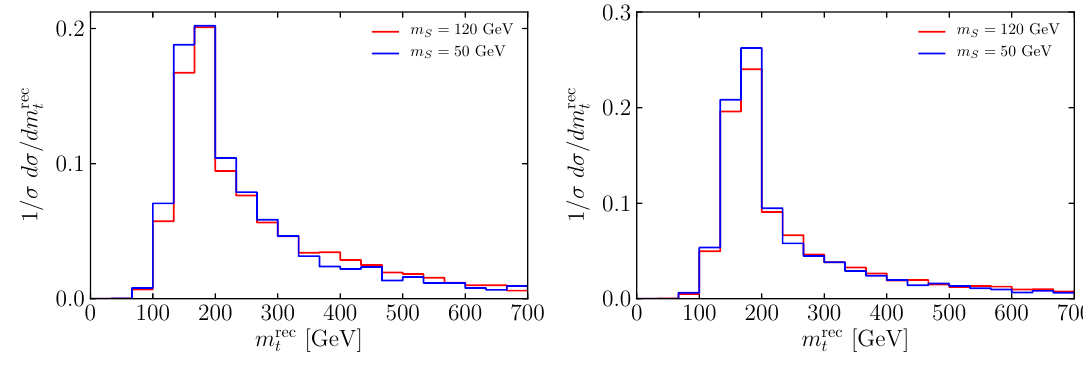
Figure 7 . The reconstructed top mass in the analysis proposed for t ! SSq; S ! (cid:22) + (cid:22) (cid:0) . In the left (right) panel, q = c ( u ). The distributions assume a collected luminosity of L = 150 fb (cid:0) 1 .